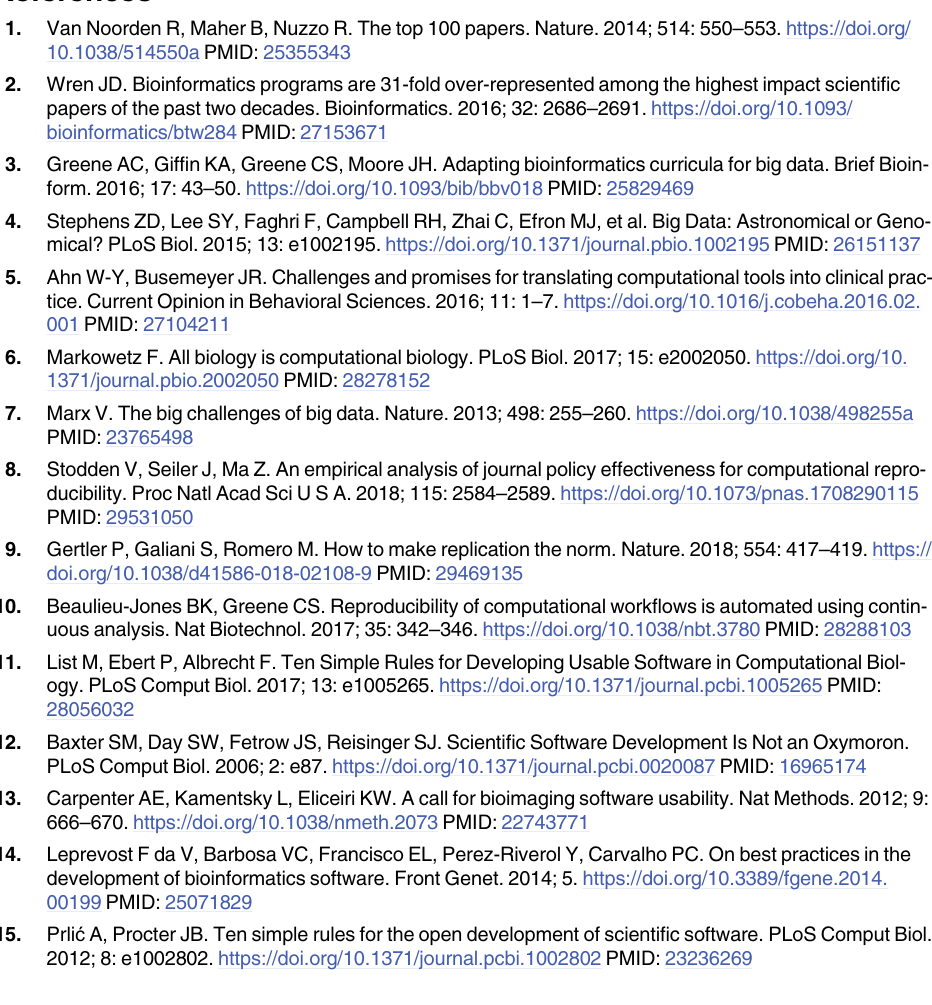
S1 Fig. Protocol to check the archival stability of a published software tool or resource. Numbers are provided for illustrative purposes and correspond to the link presented in the abstracts of the published papers considered in this study. (TIFF) S2 Fig. Protocol to verify the installability of a published software tool. (TIFF) S3 Fig. A box plot showing the time required to install tools that required a single com- mand compared with tools that required multiple commands (Mann–Whitney U test, p - value = 4.7 × 10 − 6 ).